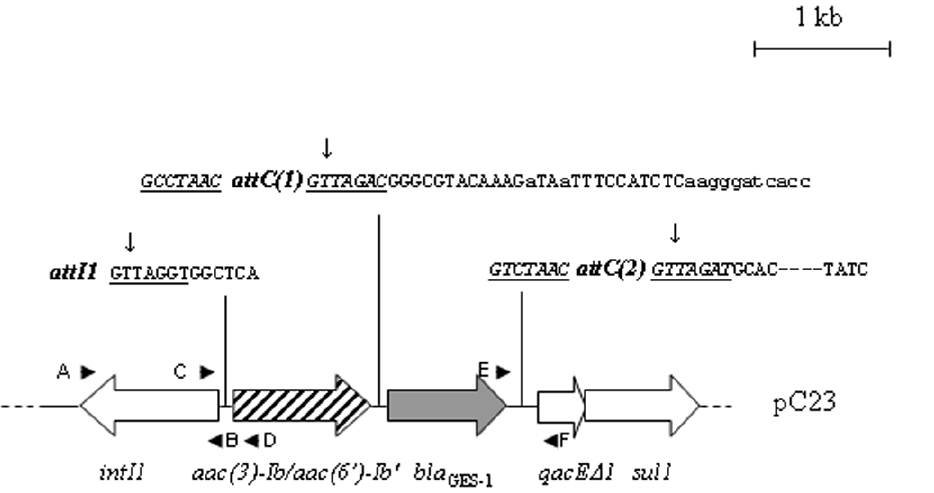
Figure 1. Schematic representation of recombinant plasmid pC23 part structure encoding the class 1 integron in P.aeruginosaPa695 (adapted from Dubois et al., 2002, accession number AF355189). The horizontal arrows indicate the translation orientation of the genes. The conserved core and inverse core sites are underlined and the cassette boundaries are represented by vertical arrows. The black arrowheads indicate the different primers described in materials and methods used for cloning the IntI1 gene and the different recombination and excision substrates: A: IntI1-3 9 -stop, B: IntI1-5 9 -Topo, C: attI1-LBamH1, D: attI1-RHindIII, E: C12T3bis and F: 3 9 CS.